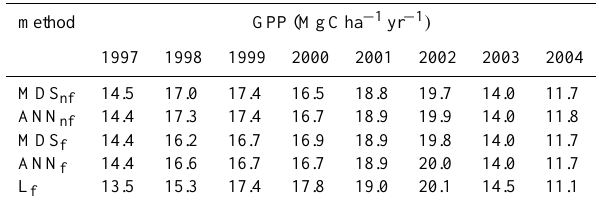
Table 2. Annual estimates of gross primary production (GPP) obtained for the forest of Hesse from eddy covariance methodol- ogy and five different flux processing methods: (i) MDS nf : non- footprint corrected, gapfilled with marginal distribution sampling (MDS; Reichstein et al., 2005) and partitioned with short term air temperature regression (STATR; Reichstein et al., 2005); (ii) ANN nf : non-footprint corrected, gapfilled with artificial neural network (ANN; Papale et al., 2003) and partitioned with STATR; (iii) MDS f : footprint corrected, gapfilled with MDS and partitioned with STATR; (iv) ANN f : footprint corrected, gapfilled with ANN and partitioned with STATR and (v) L f : footprint corrected, gap- filled and partitioned with the light-response curve model of Lass- lop et al.